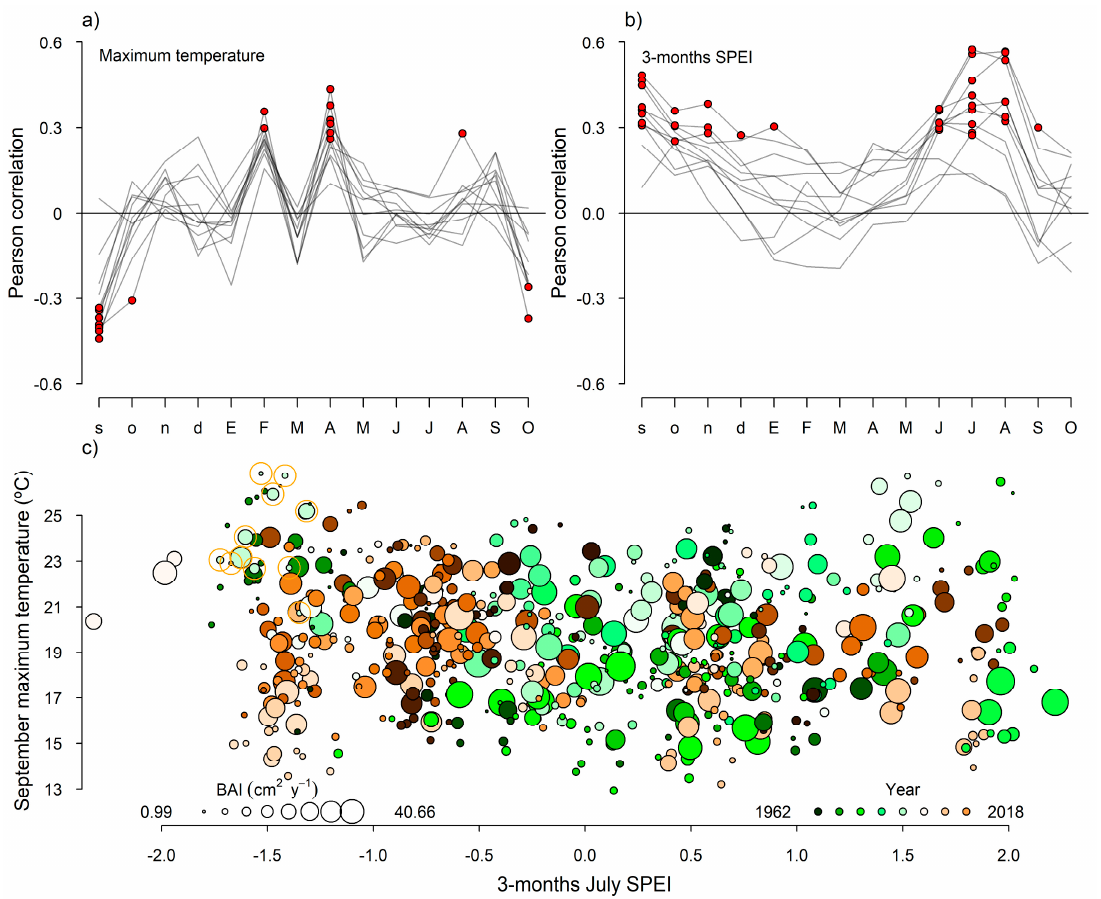
Figure 3. Growth and responses to climate of silver fir trees. The correlations between growth and maximum temperature ( a ) and the 3-month long SPEI ( b ) are shown as grey lines (red symbols indicate significant correlations). The panel in ( c ) shows how the average growth (BAI, basal area increment; symbol size is directly proportional to BAI) of trees in each stand depends on year (color scale), 3-month July SPEI (x axis) and previous September maximum temperature (y axis). Note that the 1986 year, with an extremely hot drought, resulted in the formation or extremely narrow rings (orange circles in the upper left corner).